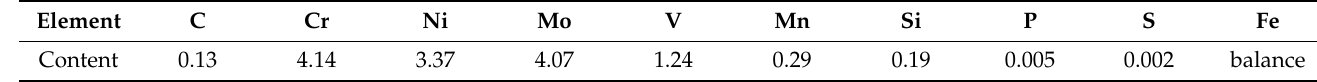
Table 1. Chemical composition of M50NiL steel (wt%).